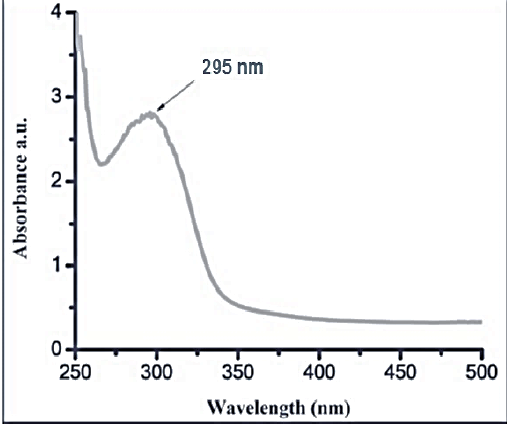
Figure 1. UV–vis spectrum of silica nanoparticles.